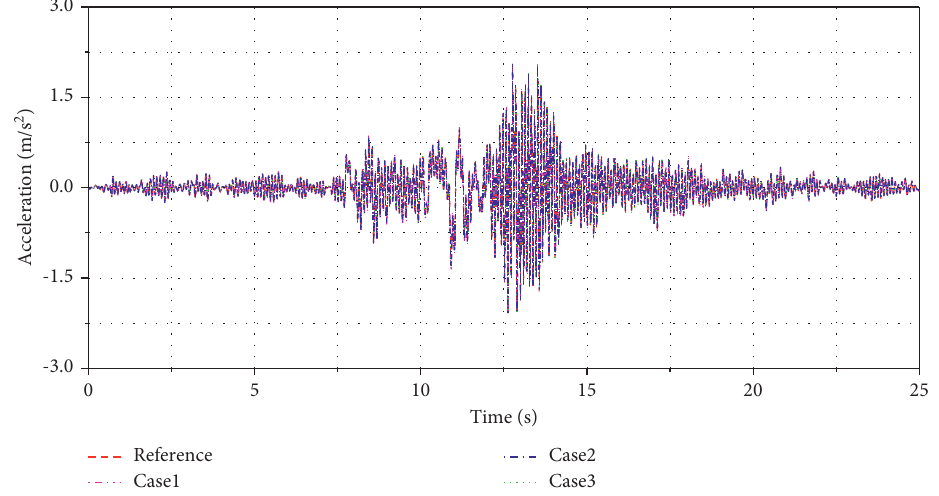
Figure 20: History of acceleration at the top of the